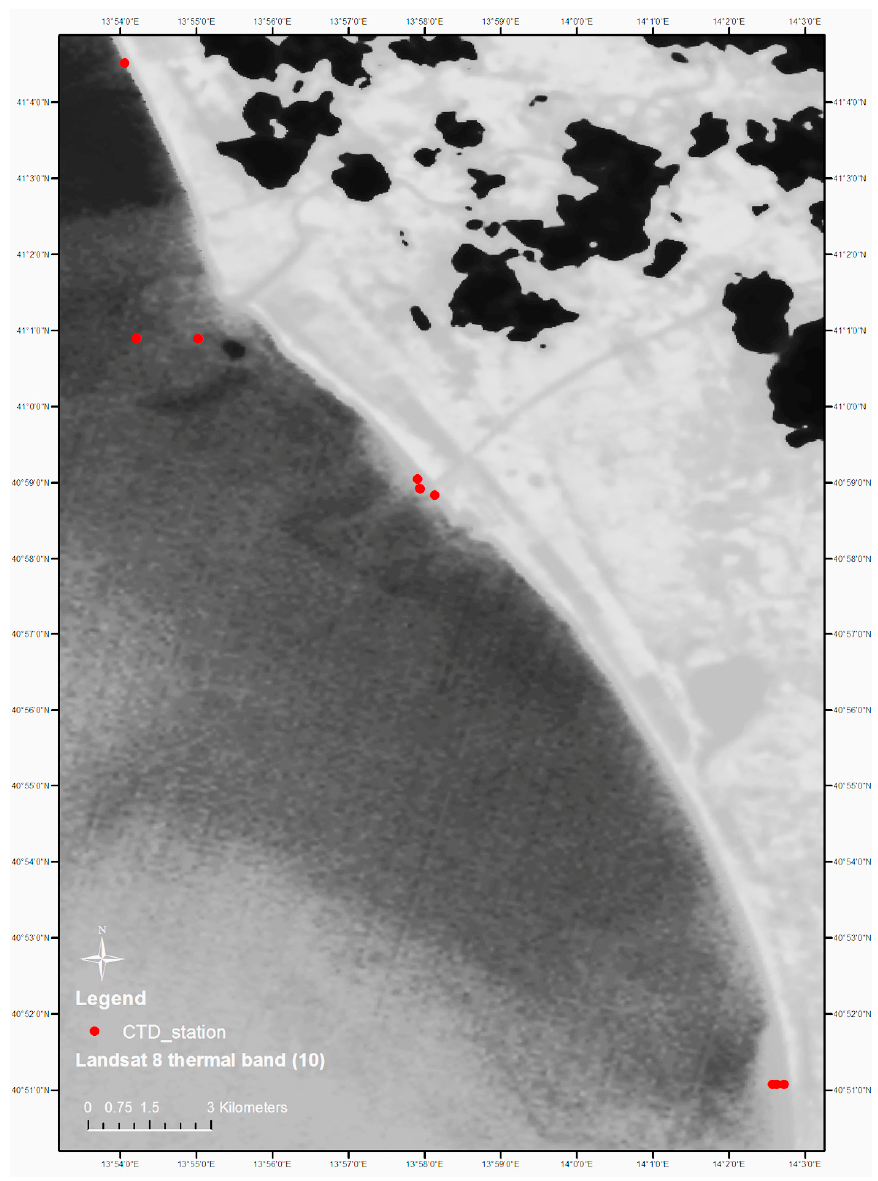
Figure 3. Landsat-8 image of the study area with dots indicating the location of the field boat sampling sites, within the channel discharge areas of interest.